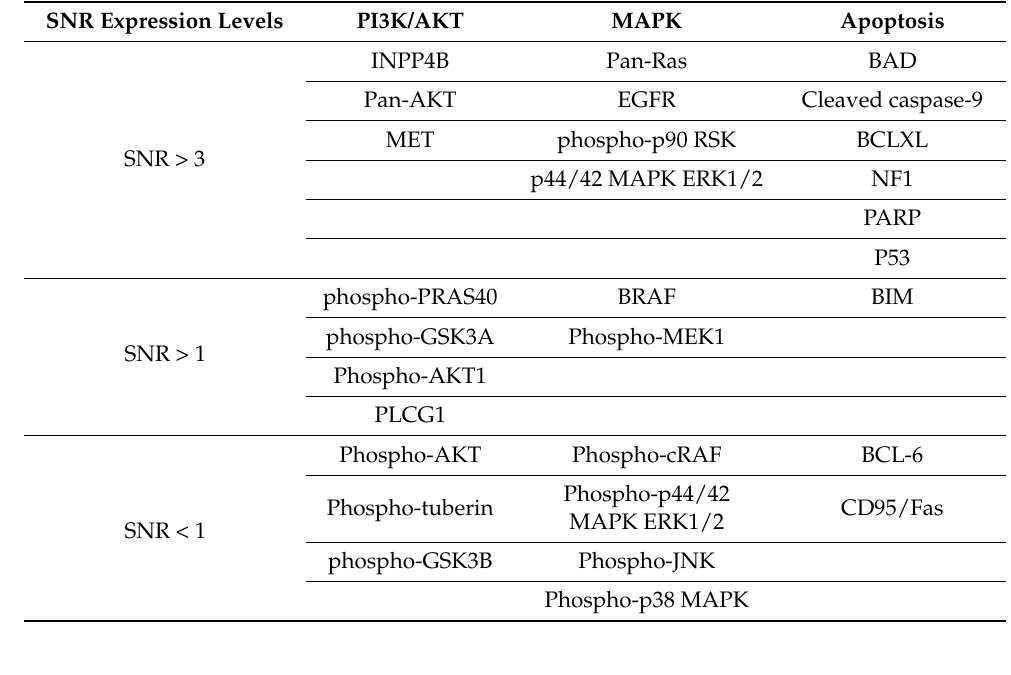
Table 2. Expression levels of signaling pathway proteins in RMS (all groups combined) as deter- mined by DSP analysis of signal to noise ratio (SNR).